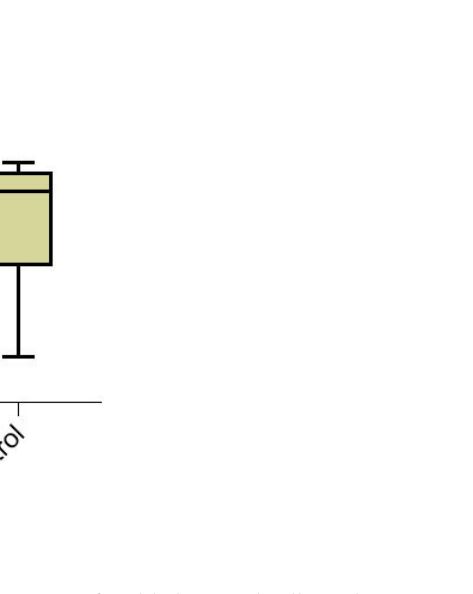
Figure 3. The box graph shows the percentage of viable bacterial cells in the two groups treated with irrigating solutions and the control group (right). The horizontal line inside the box is the median value.